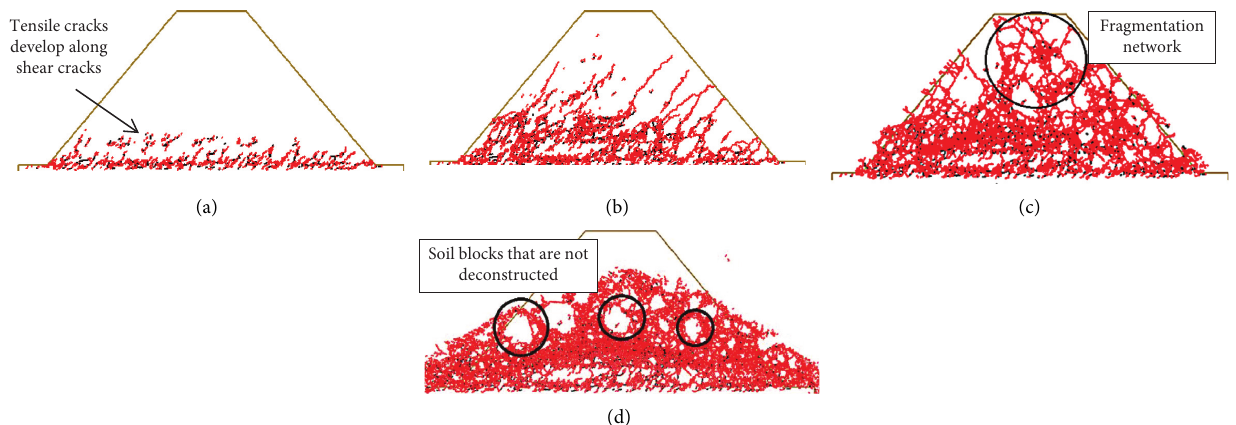
Figure 9: Crack development process with 12% moisture content. (a) At loading 0.1s. (b) At loading 0.5s. (c) At loading 1s. (d) At loading 3s.